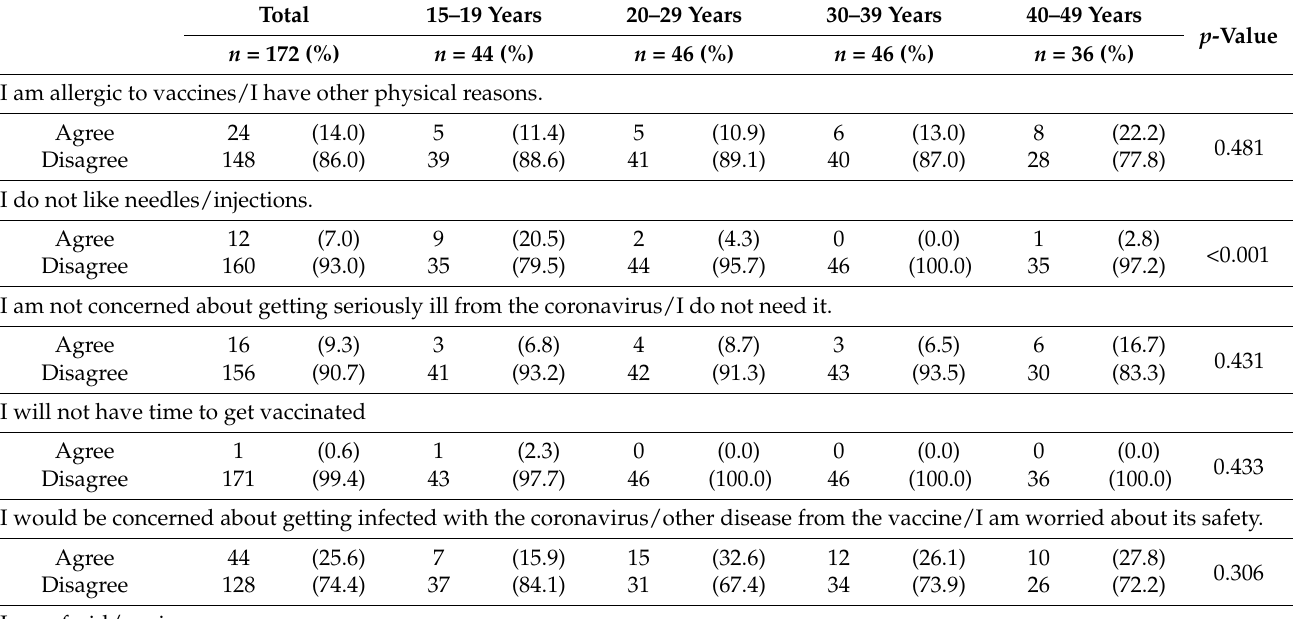
Table 2. Reasons for giving the answer, “I will not get vaccinated in the first